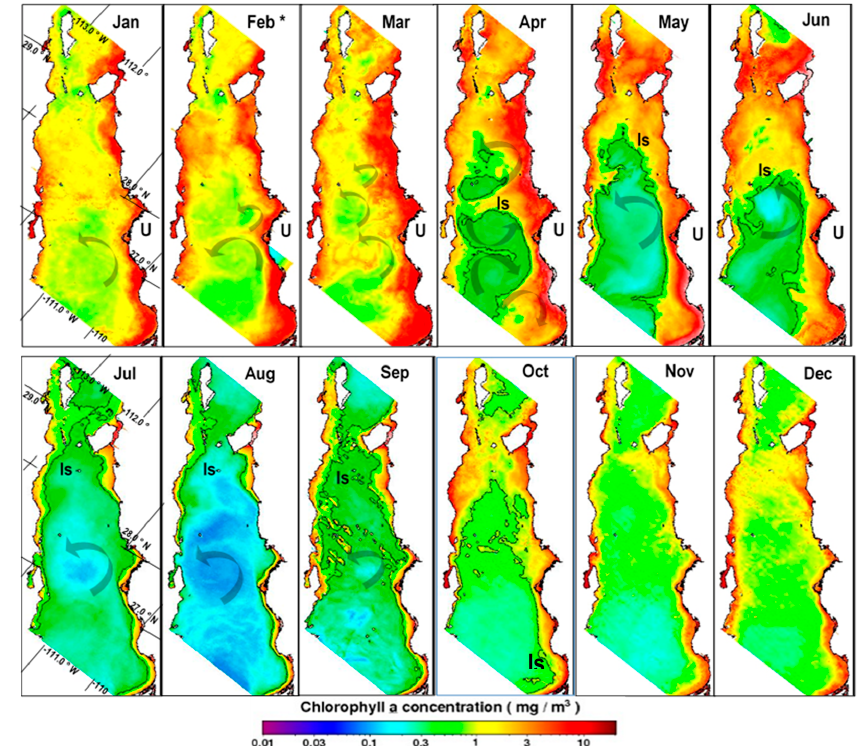
Figure 5. Satellite images of chlorophyll a mg/m 3 concentration in 2012. Isoline of Chl-a of one mg/m 3 (Is) and upwelling (U). Arrows in the clockwise direction indicate anti-cyclonic gyres, and those in the counterclockwise direction indicate cyclonic gyres.